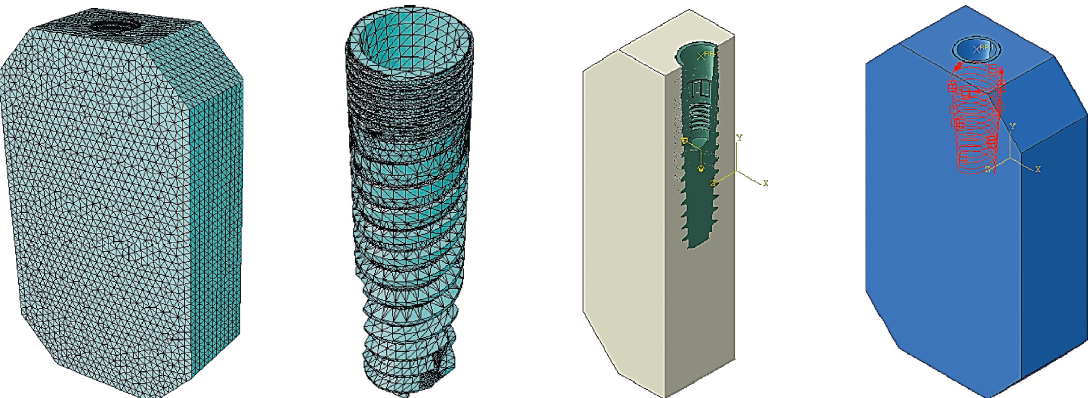
Figure 3: Areas of contact between the two models, force on the screw, implant screw grid, and bone